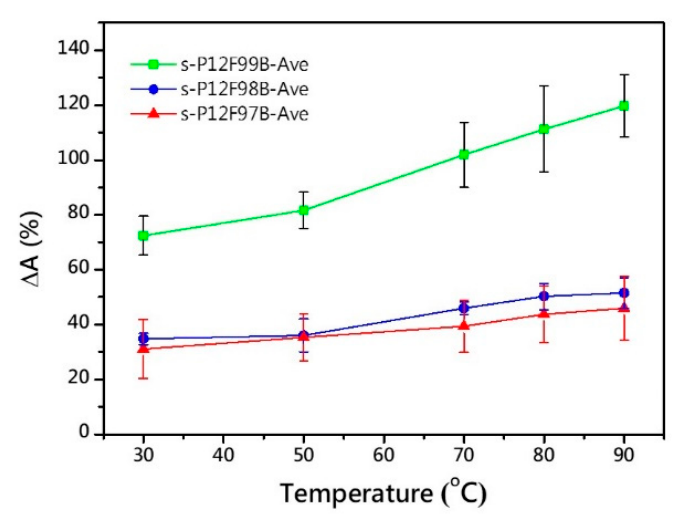
Figure 5. Swelling as a function of temperature for